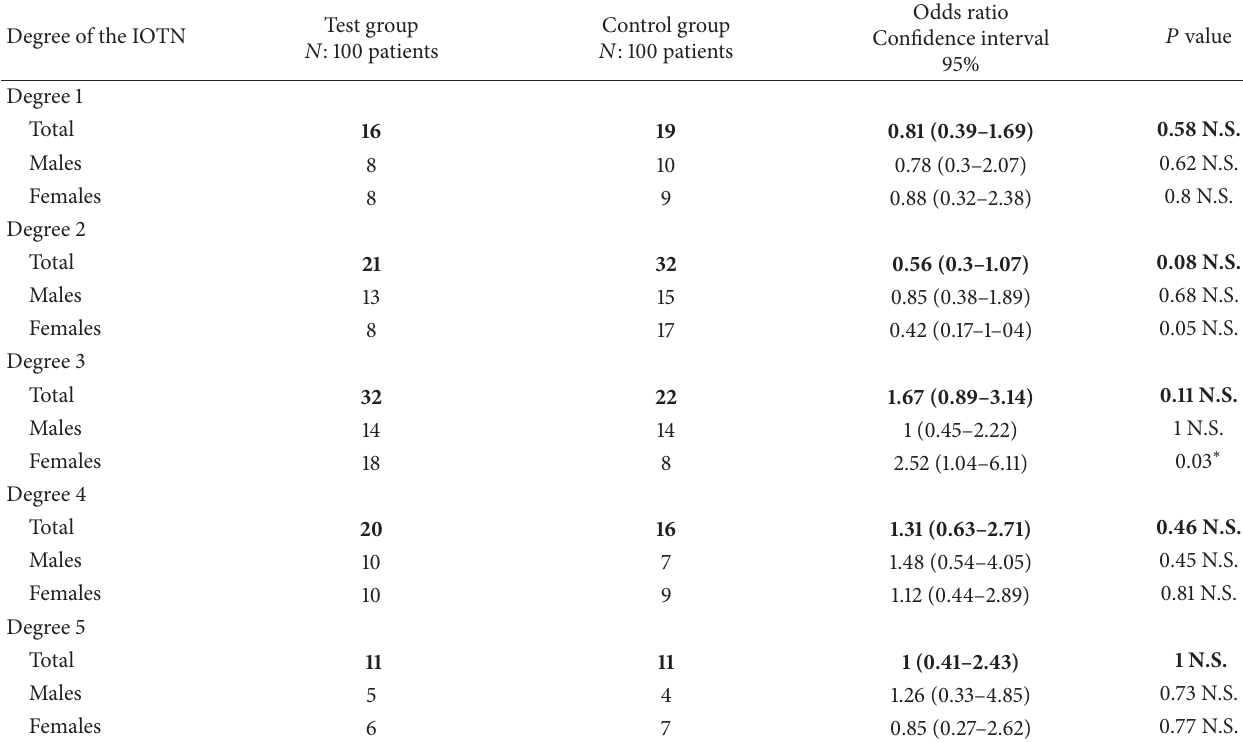
Table 3: Prevalence of the IOTN (degrees 1–5) in the test and in the control group, with the indication of significant differences. Test group Degree of the IOTN 𝑁 : 100